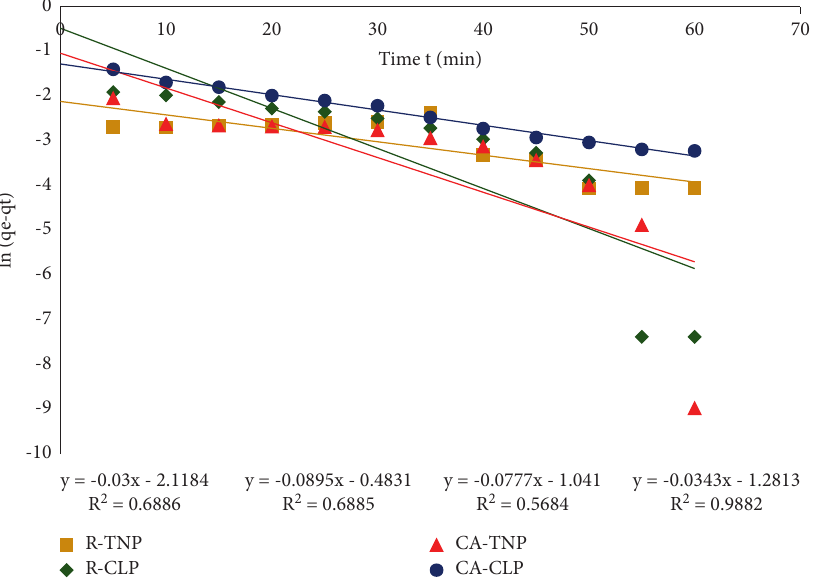
(CA-TNP and CA-CLP), elaborated in Table 4. R 2 values of all adsorbents reflect the high fitness of this kinetic model than the pseudo-first-order model.